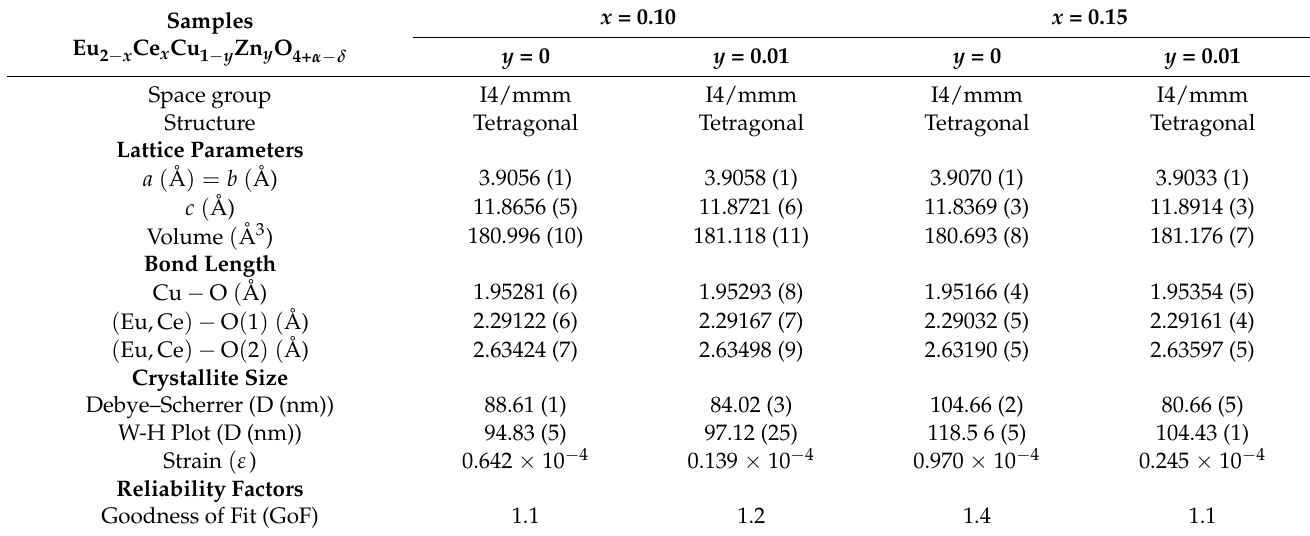
Table 1. Structural parameters of Eu 2− x Ce x Cu 1− y Zn y O 4+ α − δ with x = 0.10; 0.15 and y = 0; 0.01.